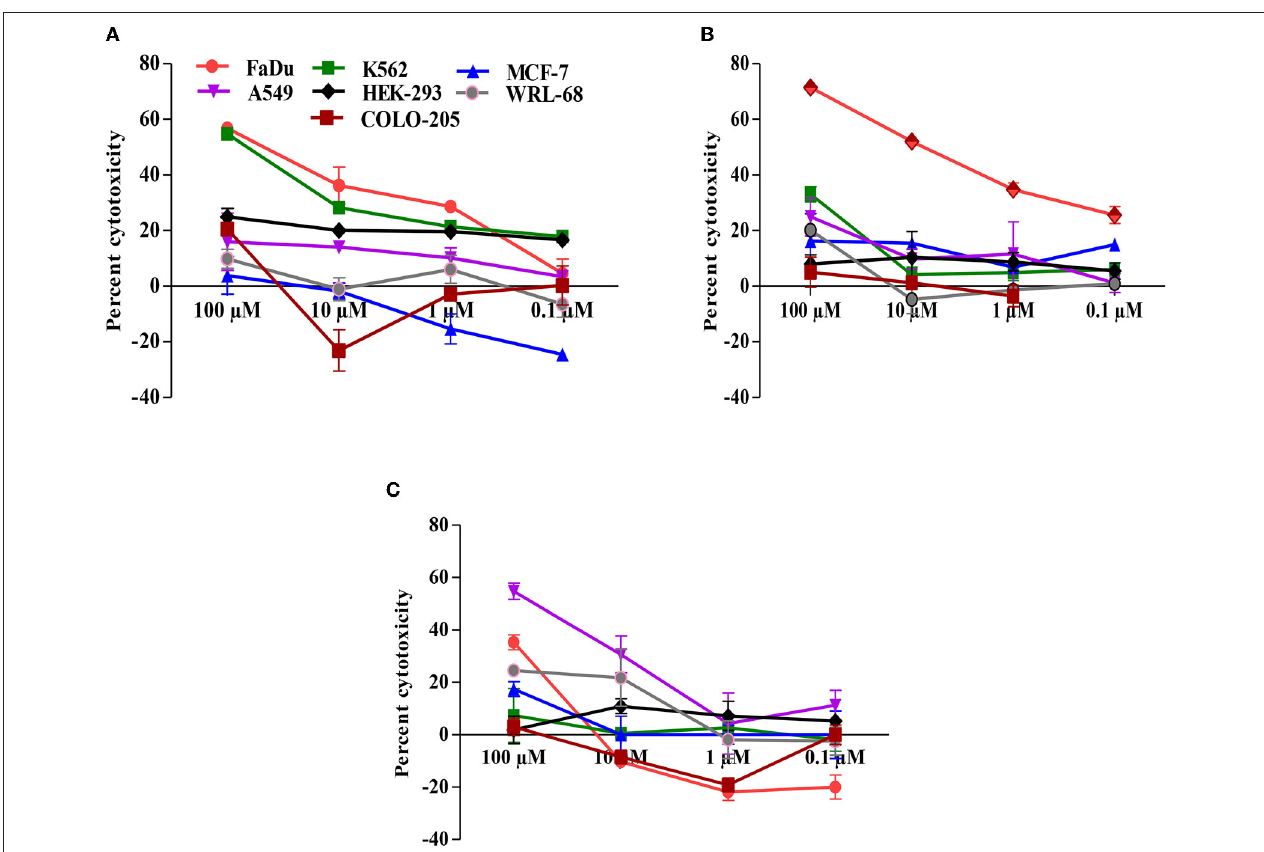
FIGURE 1 | Carvacrol dose-dependently suppresses the growth of cancer cell lines. (A) Sulpho rhodamine B (SRB) dye was used to analyse the anti-proliferative effect of carvacrol in cancer cell lines. (B) 3-(4,5-dimethylthiazol-2-yl)-2,5-diphenyl tetrazolium bromide (MTT) dye was used to determine the effect of carvacrol in cancer cell lines. (C) Neutral red uptake (NRU) dye was used to detect the potential of carvacrol in cancer cell lines. Data are presented as mean ± SD ( n = 3). Comparatively, carvacrol showed a potent effect against the FaDu cell line.